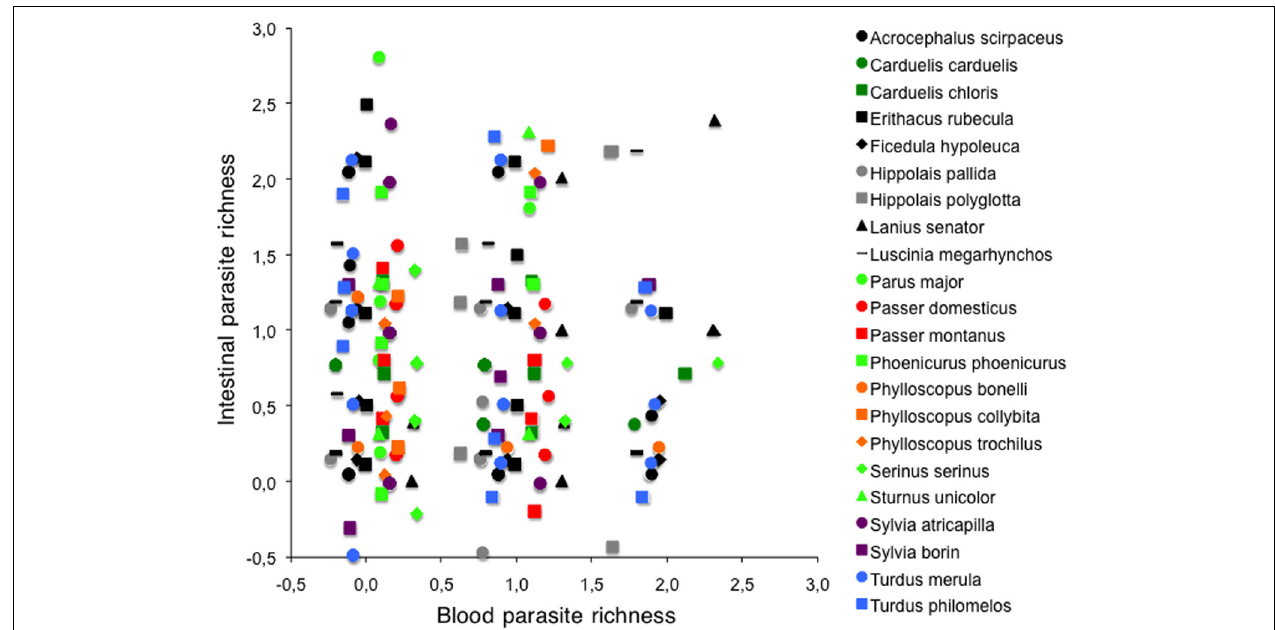
FIGURE 1 | Relationship between intestinal and blood parasite richness for 354 individual birds of 22 different passerine species after controlling for the effects of time of capture (morning or afternoon) on intestinal